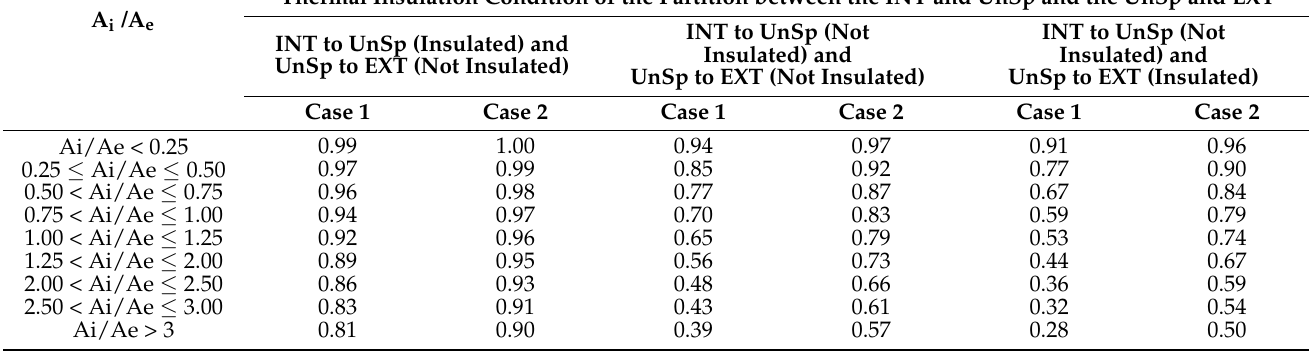
Table 8. Values for the adjustment factor (b) set by the DB-HE (adapted from [26]). Thermal Insulation Condition of the Partition between the INT and UnSp and the UnSp and EXT A i /A e INT to UnSp (Not INT to UnSp (Not INT to UnSp (Insulated) and Insulated) and Insulated) and UnSp to EXT (Not Insulated) UnSp to EXT (Not Insulated) UnSp to EXT (Insulated) Case 1 Case 2 Case 1 Case 2 Case 1 Case 2 Ai/Ae < 0.25 0.99 1.00